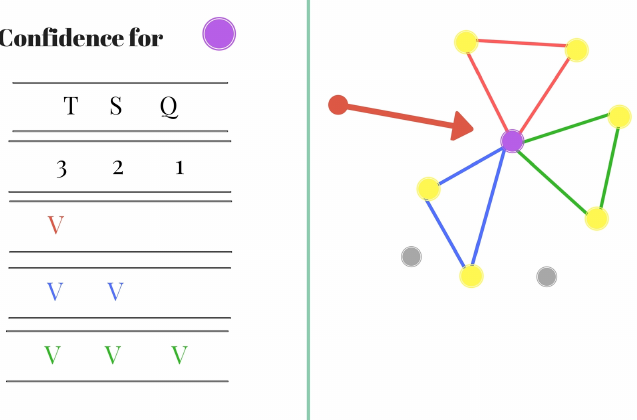
Figure 7. Calculating the match confidence for triplets with several keys.